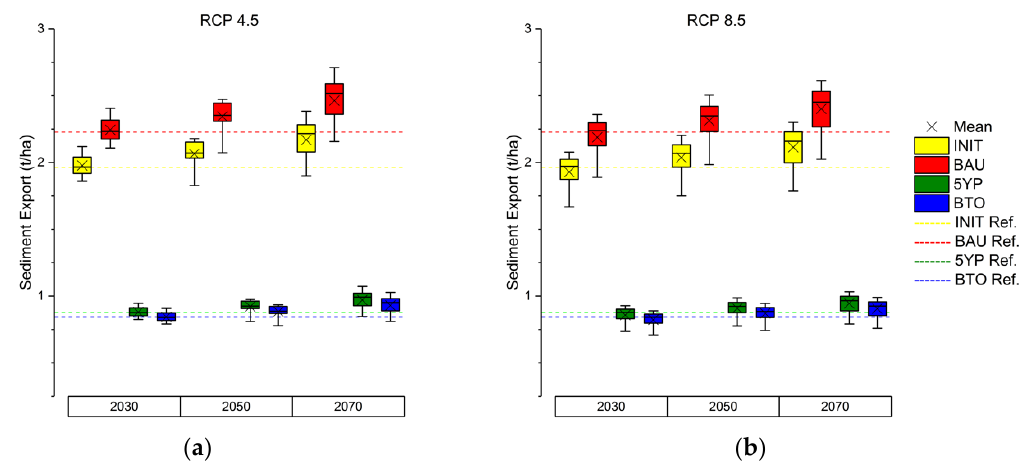
Figure 5. Annual average sediment export in Nabanhe Reserve calculated with InVEST using ensemble precipitation data (9 GCMs) of two Relative Concentration Pathways (RCP 4.5 ( a ) and RCP 8.5 ( b ) of IPCC5) for the time slices of 2030 (20-year average from 2020–2040), 2050 (20-year average from 2040–2060) and 2070 (20-year average from 2060–2080). Boxes and whiskers show the 25/75 and 10/90 percentiles respectively. Lines in boxes show the ensemble median, whereas crosses show the ensemble mean. Colors represent land use conditions: Initial case of 2015 (INIT, yellow), Business-As-Usual scenario (BAU, red), 5-years-plan scenario (5YP, green), Balanced-Trade-Offs scenario (BTO, blue). The dotted lines shows annual average sediment export calculated with long-term precipitation data as a baseline (WorldClim v1.4. [39,40]).